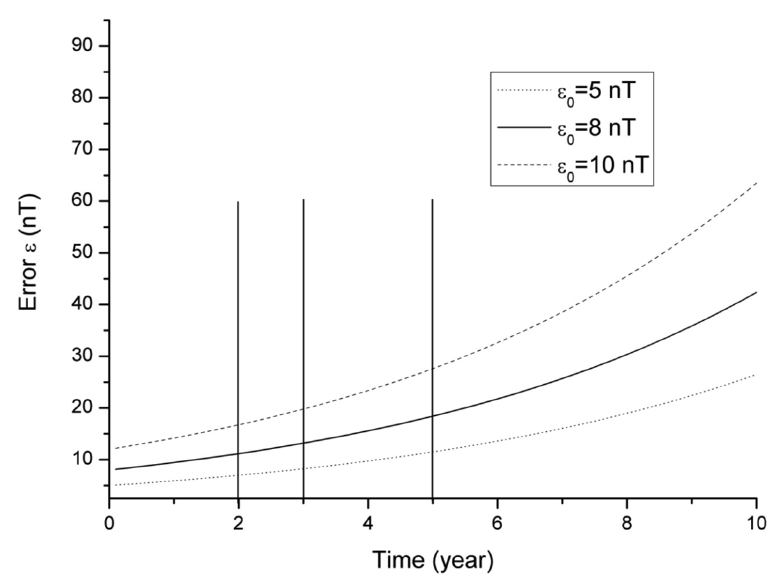
Figure 3. Exponential divergence in time of some typical initial errors (of 5 nT, 8 nT and 10 nT) in repeat-station surveys in the case of a chaotic geomagnetic field. Vertical lines are taken at 2 years, 3 years and 5 years. While the error after 5 years is relatively large, those at the first two epochs are accepted for any extrapolation in time of eventual magnetic